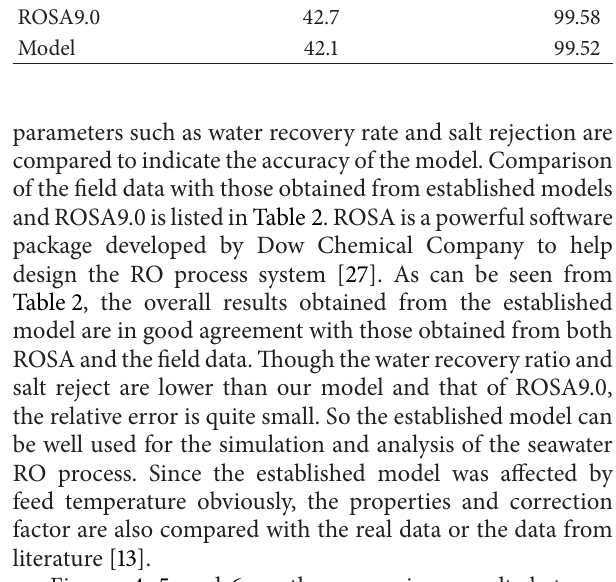
Field data of a RO process are used for model verifi- cation and parameter identification. The key performance